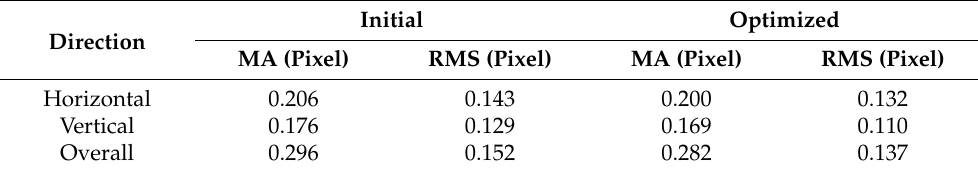
Table 2. The reprojection error under the initial parameters and optimized parameters.